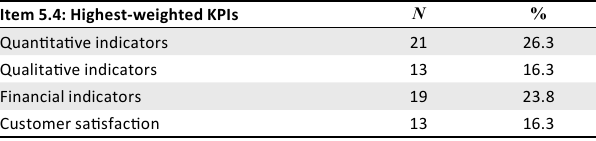
TABLE 8: Highest-weighted KPIs allocated to call centre managers.